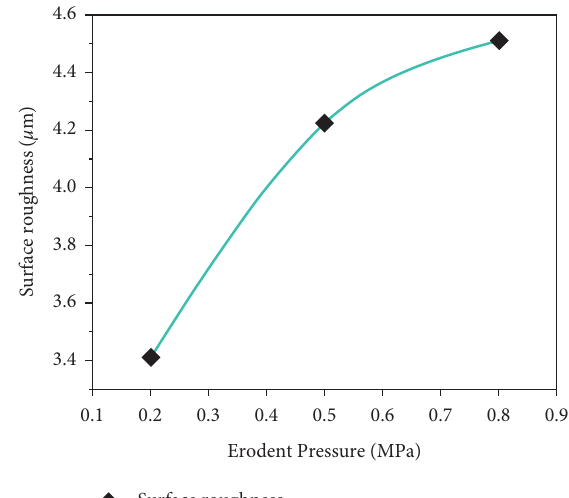
Figure 2: Effect of blasting pressure concerning surface roughness value.